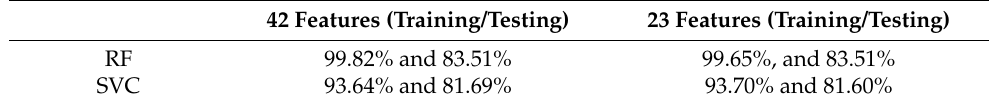
Table 8. Binary classification accuracy when multiple features were used.